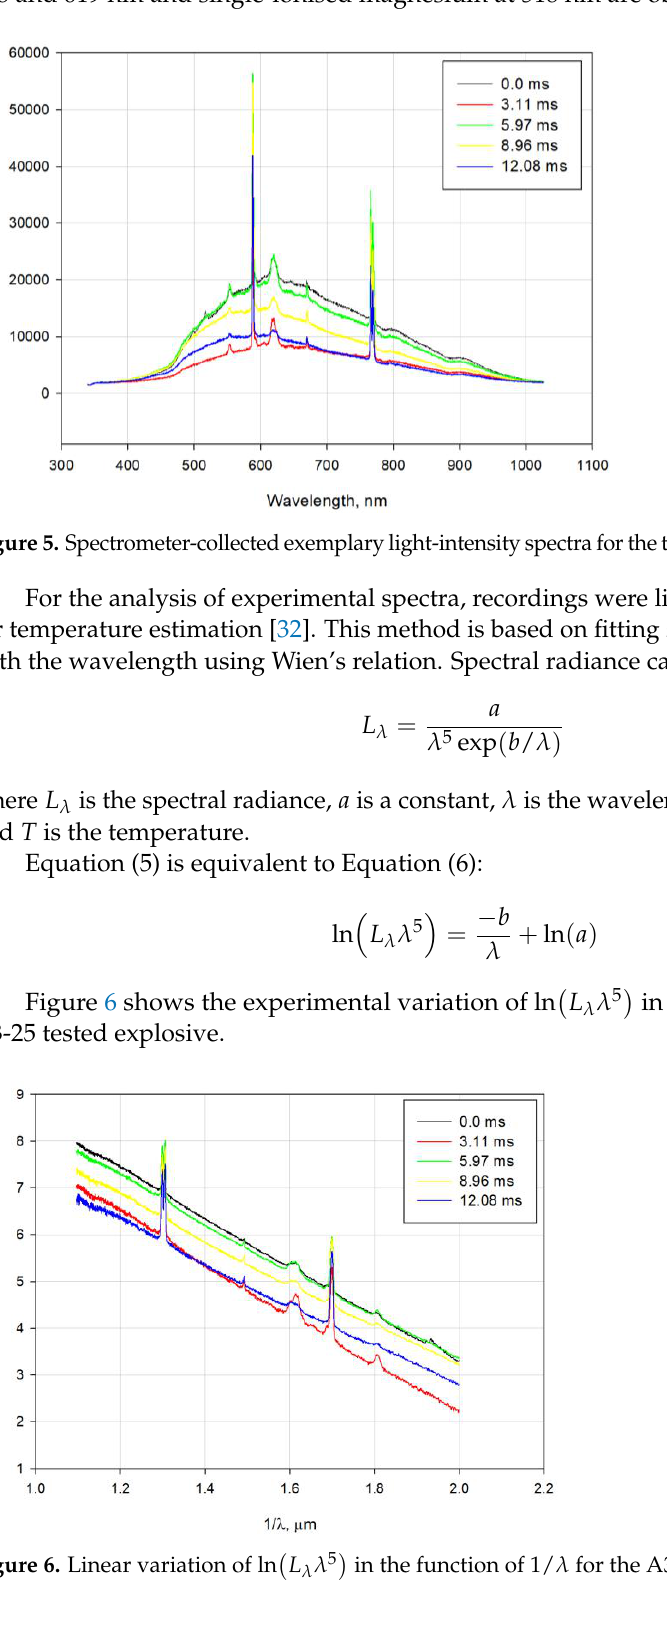
Figure 6. Linear variation of ln(𝐿 𝜆 𝜆 5 ) in the function of 1 𝜆⁄ for the A3-25 explosive .